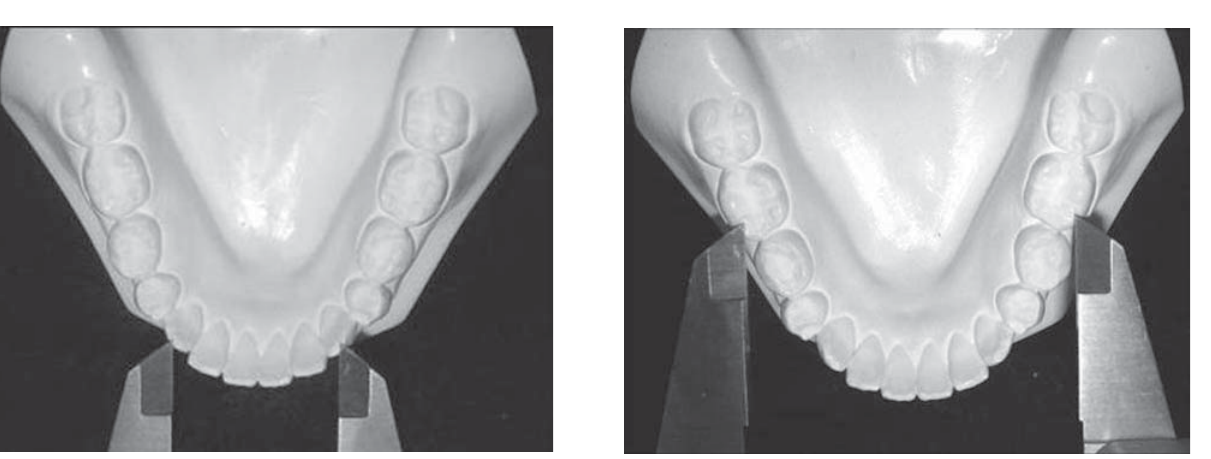
Figure 1- Measurement of intercanine distance Figure 2- Measurement of intermolar